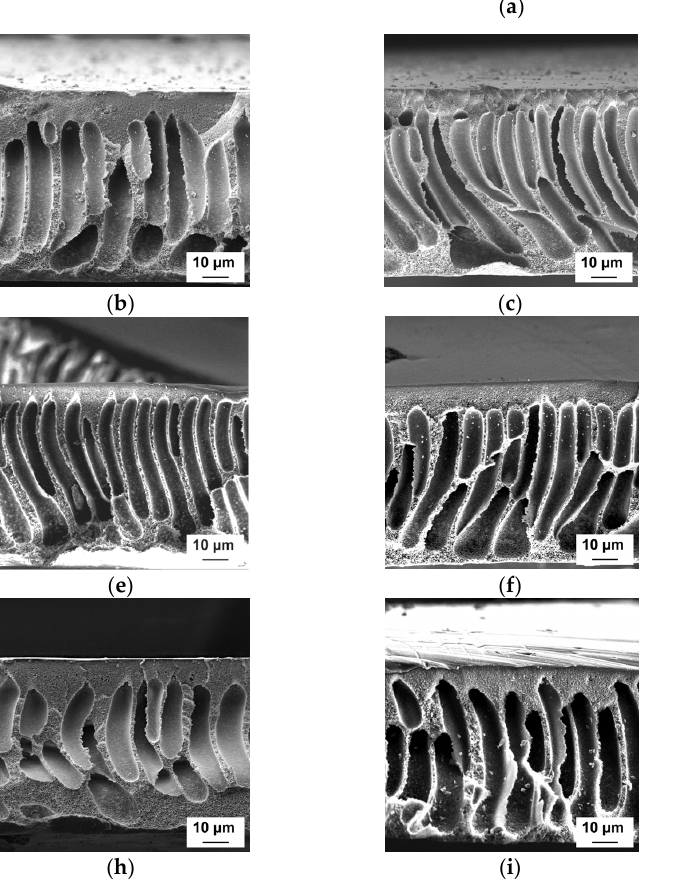
Figure 2. SEM micrographs of the cross ‐ sections of the reference PSF membrane ( a ) and membranes, modified by the introduction of PAA to the precipitation bath ( b – j ): ( a ) PA ‐ 0; ( b ) PA ‐ 100 ‐ 1.0; ( c ) PA ‐ 250 ‐ 1.0; ( d ) PA ‐ 450 ‐ 1.0; ( e ) PA ‐ 100 ‐ 1.5; ( f ) PA ‐ 250 ‐ 1.5; ( g ) PA ‐ 450 ‐ 1.5; ( h ) PA ‐ 100 ‐ 2.0; ( i ) PA ‐ 250 ‐ 2.0; and ( j ) PA ‐ 450 ‐ 2.0.